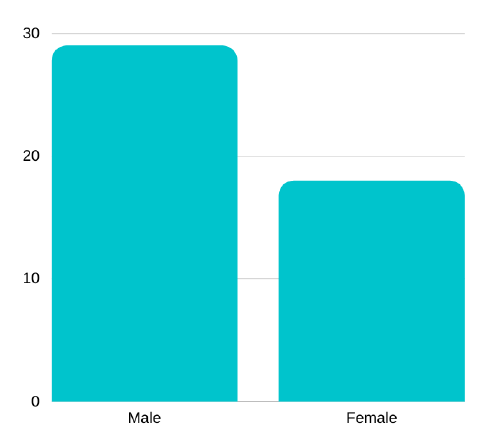
Figure 8. The demography of the participants’ gender .